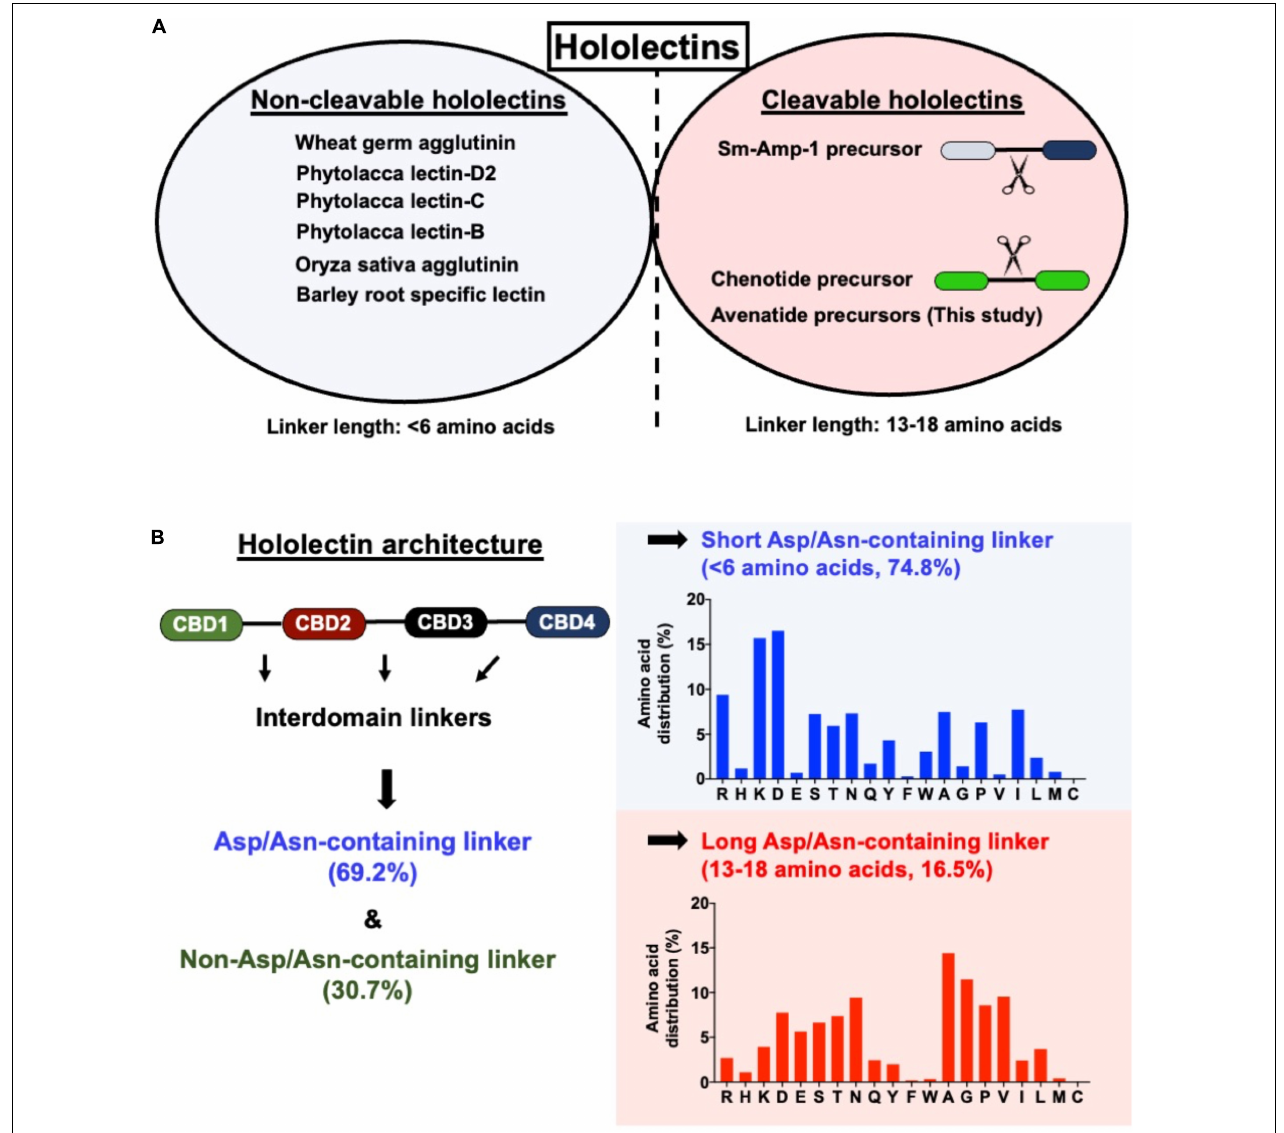
FIGURE 7 | (A) Comparison of linker length of reported cleavable hololectins (13–18 amino acids) and non-cleavable hololectins (4–6 amino acids). (B) Database search revealed a total of 121 hololectin precursor sequences with 280 hololectin linkers from NCBI and Onekp database. 69.2% are Asn/Asp-containing